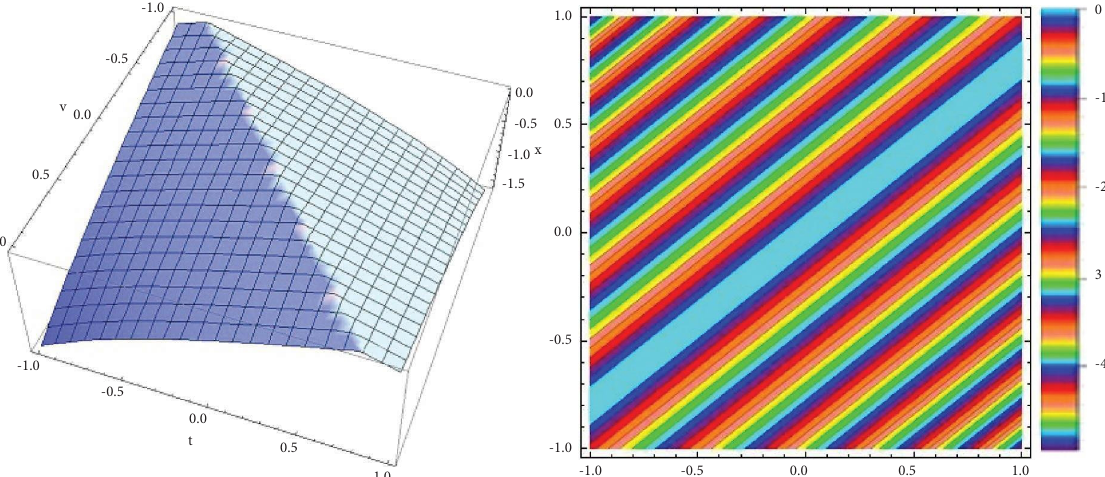
Figure 3: Sketched the compacton type soliton from (11) when ω � 0 .